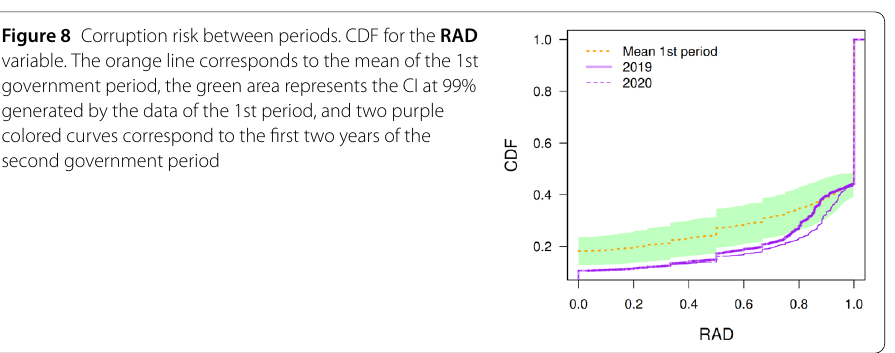
Figure 8 Corruption risk between periods. CDF for the RAD variable. The orange line corresponds to the mean of the 1st government period, the green area represents the CI at 99% generated by the data of the 1st period, and two purple colored curves correspond to the first two years of the second government